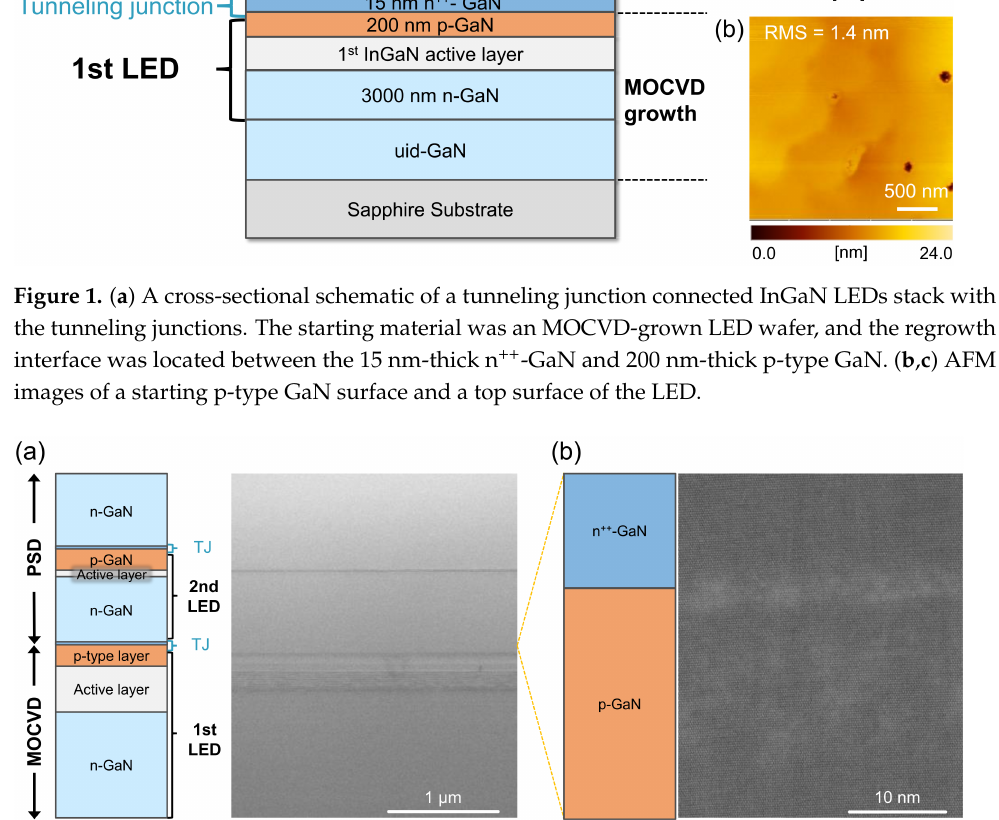
Figure 2. ( a ) A cross-sectional Z-contrast TEM image of the LED stack. ( b ) a high-resolution-TEM image of the regrowth